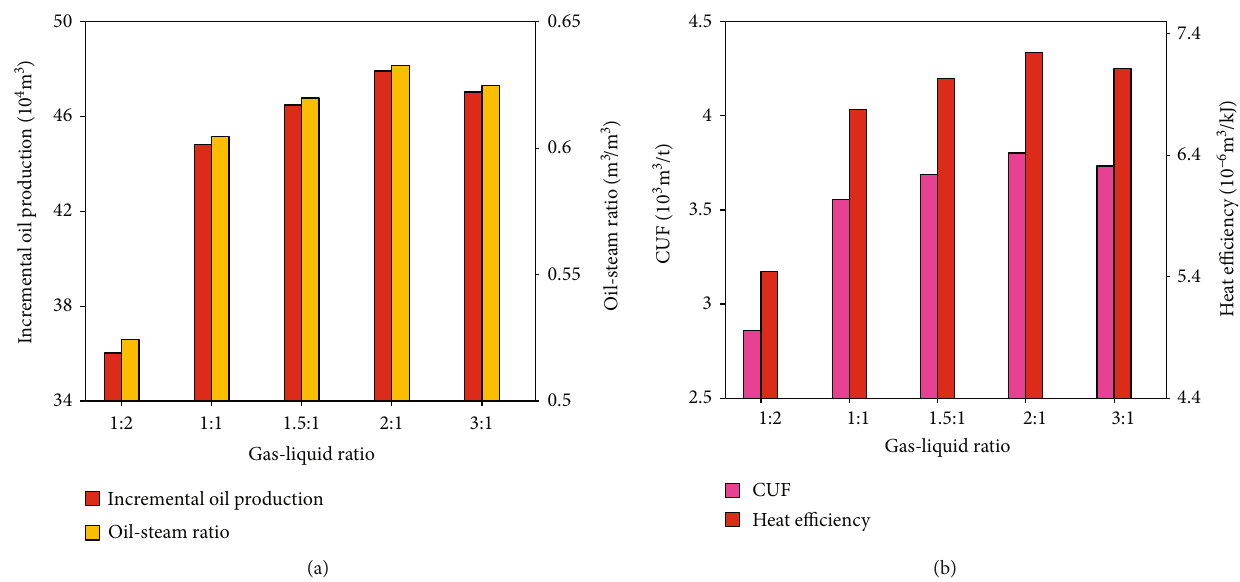
Figure 5: E ff ect of the gas-liquid ratio: (a) incremental oil production and oil-steam ratio; (b) CUF and heat e ffi ciency.